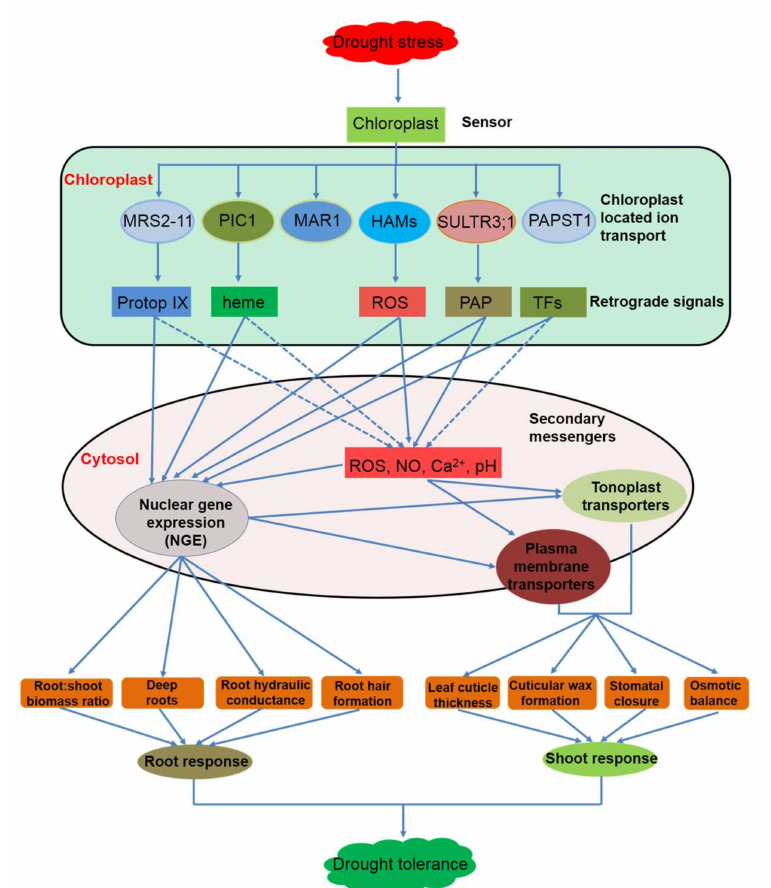
Figure 3. A schematic diagram of retrograde signals and potential mechanisms in regulating plant drought tolerance. Drought can be perceived by chloroplasts. Chloroplast-located ion channels participate in biosynthetic processes of retrograde signals, such as Mg-Protop IX [45], heme [48], ROS [100], and PAP [117], which target either nuclear genes expression (NGE) [48,54,116] or secondary messengers [55]. Secondary messengers and NGE regulate plasma membrane or tonoplast ion transporters [171], triggering the root and shoot responses to drought. Dotted blue arrows: potential interactions. Abbreviations: see legends of Figures 1 and